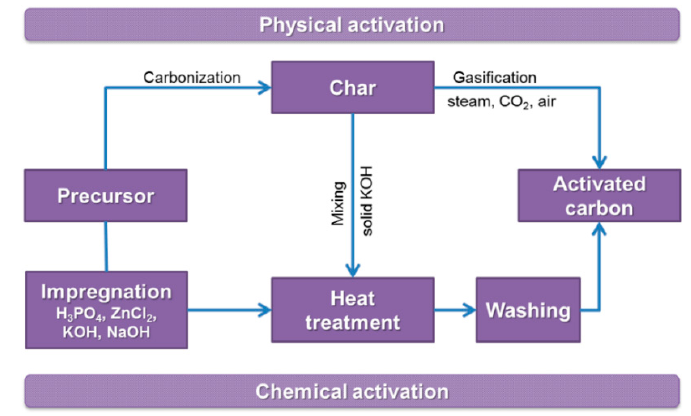
Figure 4. AC preparation by physical and chemical activation.